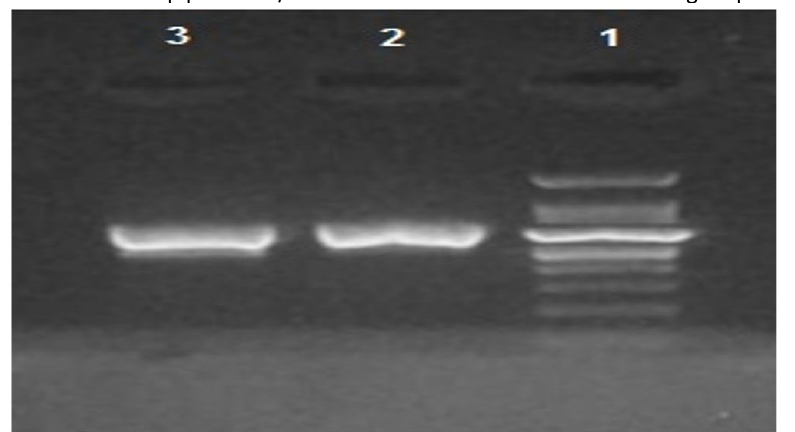
Fig. 1. Gel electrophoresis of PCR amplified class-I integron gene in A. baumannii isolates. Lane 1 was1kb DNA ladder, lane 2 and 3 were (160 bp) amplicon of class-I integron gene positive A. baumannii isolates.